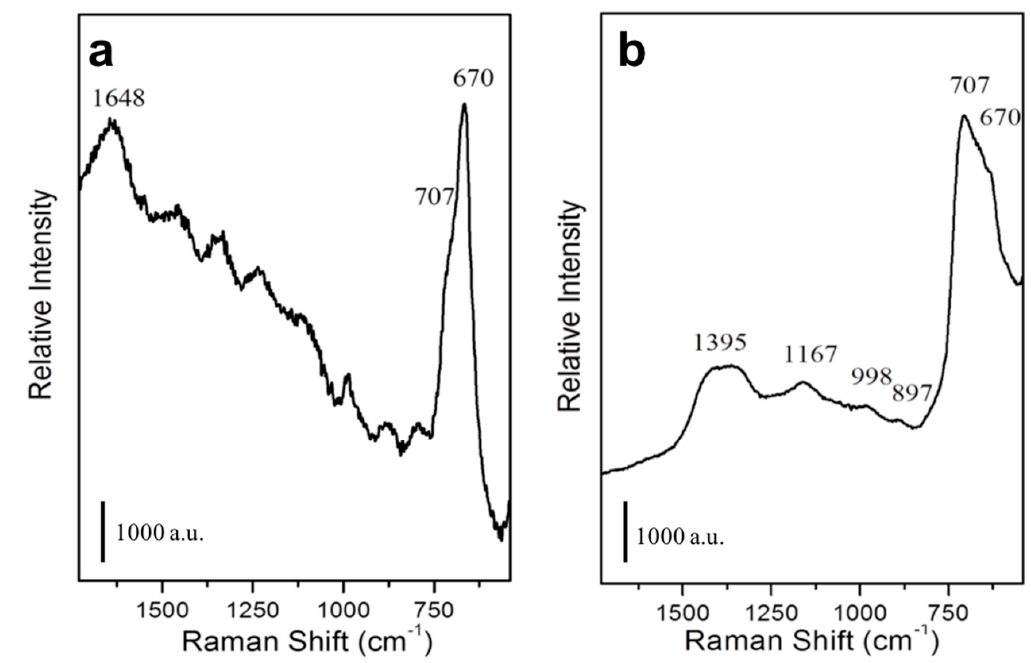
Figure 7. Characterization of mAb-functionalized magnetic nanoparticles. Raman spectra of not functionalized ( a ) or mAb-functionalized ( b ) MNPs.